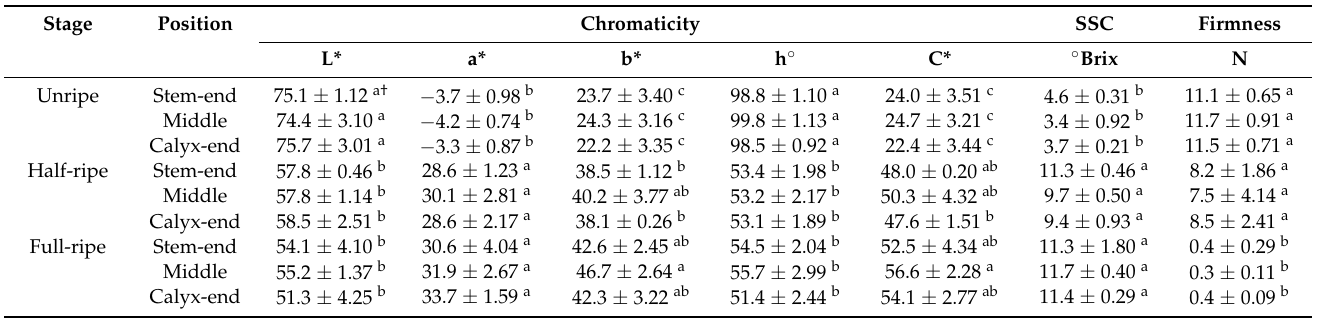
Table 3. Pulp chromaticity, soluble solid contents, and firmness (N) of “Tainung No. 2” Red papaya ( Carica papaya ) at 3 parts across ripening stages unripe at 16 weeks after anthesis (WAA), half-ripe at 18 WAA, and full-ripe at 20 WAA.